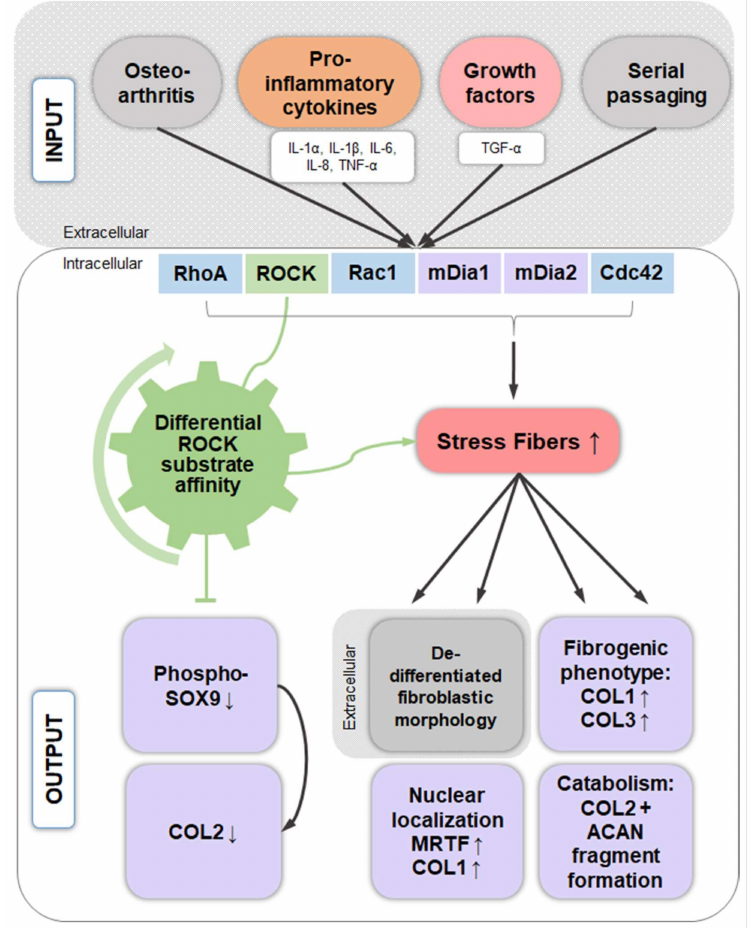
Figure 14. CH phenotype regulation, e.g., in OA or through serial passaging, pro-inflammatory cytokines, and/or growth factors control CH function through SF formation and the actin-regulating signaling pathways RhoA/ROCK/Rac1/mDia1/mDia2/Cdc42. SF formation in CHs induces a dedifferentiated fibroblastic morphology, a fibrogenic (increased COL1 and COL3 expression) and catabolic (formation of COL2 and aggrecan fragments) phenotype, and increased COL1 expression, induced by the nuclear localization of MRTF. This review theorized that in CHs phosphorylation of SOX9 (and subsequently increased COL2 expression as chondrogenic phenotype marker) by ROCK is effectively sidelined in favor of other SF promoting ROCK substrates (LIMK2, ezrin, and MLC), based on a differential affinity of various ROCK substrates, explaining how it is molecularly possible that dedifferentiation induces low COL2 expression but high SF formation. Abbreviations: COL1: type I collagen, COL2: type II collagen, COL3: type III collagen, IL-1 α : interleukin 1 α , IL-1 β : interleukin 1 β , IL-6: interleukin 6, IL-8: interleukin 8, MRTF: myocardin-related transcription factor, ROCK: Rho-kinase, SOX9: SRY-box transcription factor 9, TGF- α : transforming growth factor α , TNF- α : tumor necrosis factor α . The up and down arrows indicate an increase or